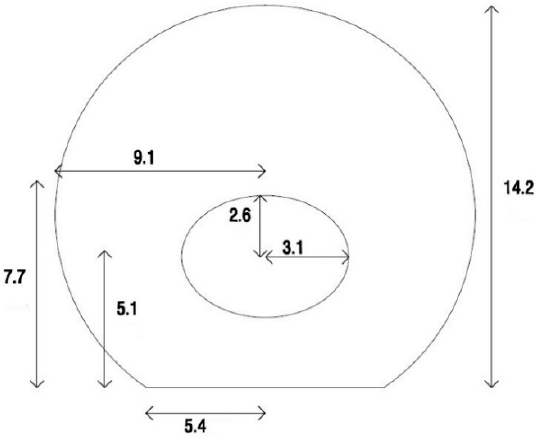
Figure 1. Geometry of a cell and its dimensions ( μ m).